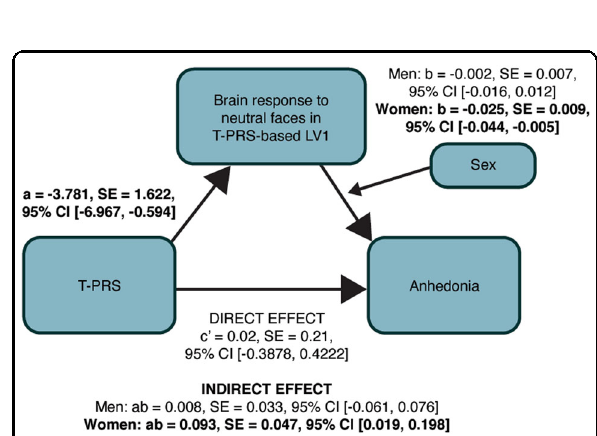
Fig. 4 Brain response to neutral faces in T-PRS-based LV1 regions as a mediator of the relationship between T-PRS and anhedonia. Brain response to neutral faces in T-PRS-based LV1 regions mediated the relationship between T-PRS and anhedonia in females (ab = 0.093, SE = 0.047, 95% CI [0.019; 0.198]) but not males (ab = 0.008, SE = 0.033, 95% CI [ − 0.061;